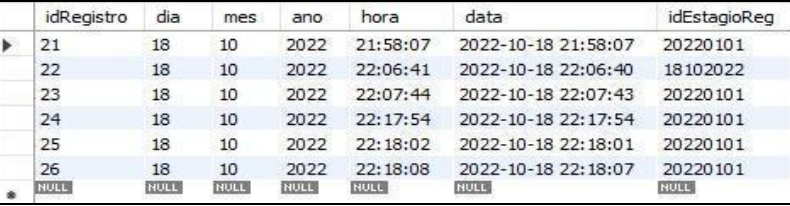
Figure 30: Table "time_sheet".